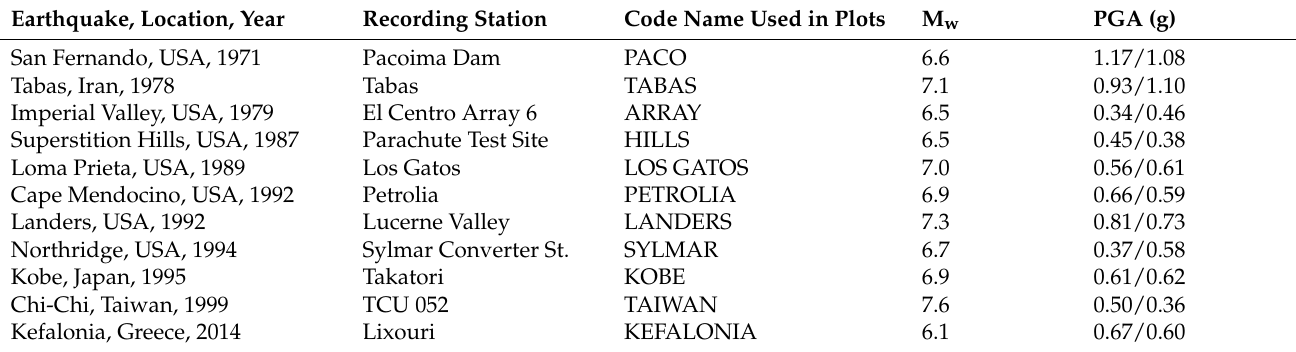
Table 3. Near-fault seismic motions